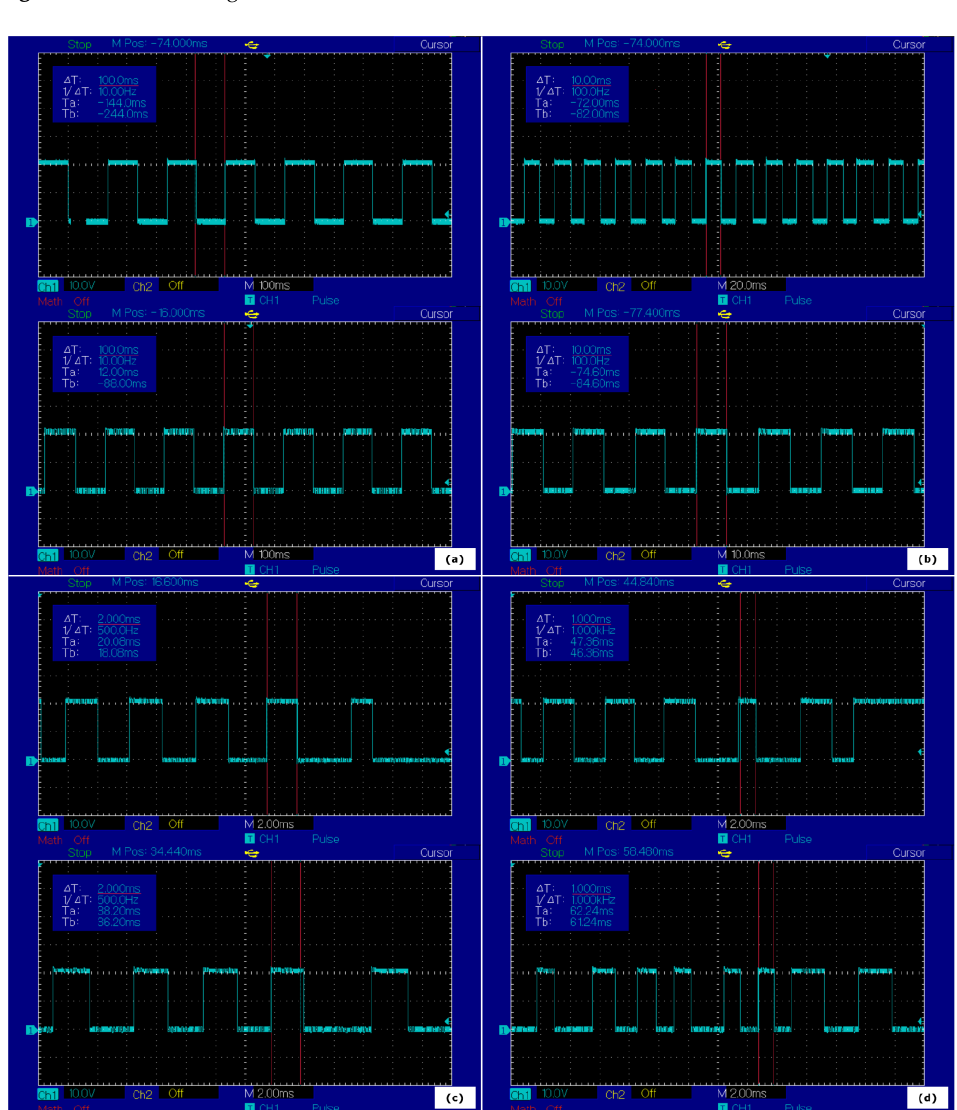
Figure 8. Generated digital signal based on the heartbeat event received and transmitted by the gateway application for case study 1 (above) and case study 2 (below) at ( a ) 100 ms; ( b ) 10 ms; ( c ) 2 ms; ( d ) 1 ms. ( c ) 2 ms; ( d ) 1